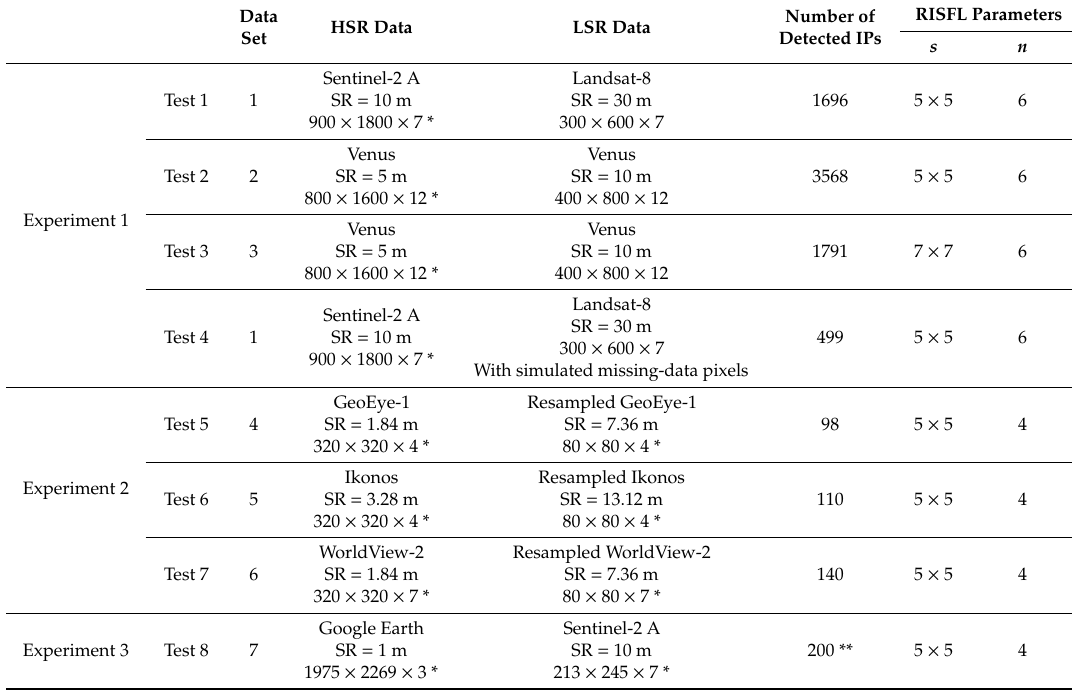
Table 1. Summarized information about the data sources used in the experimental tests 1 to